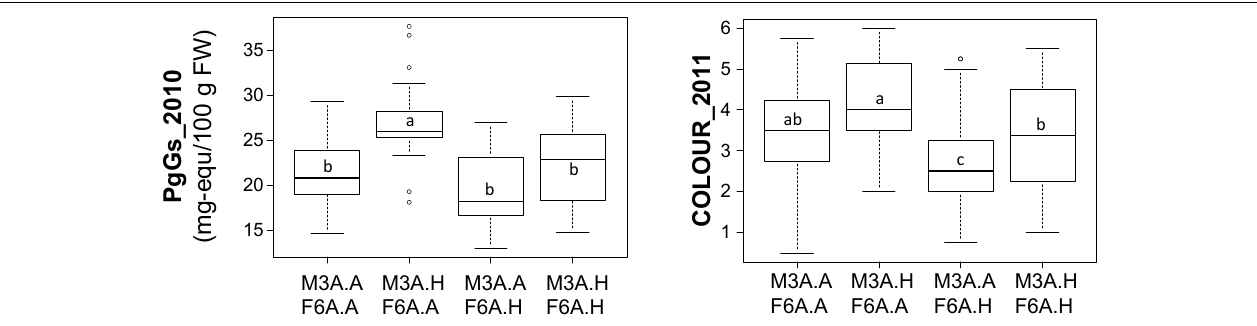
FIGURE 2 | Contribution of the M3A and F6A quantitative trait loci (QTLs) to colour-related trait values. Effect of M3A and F6A alleles on PgGs content and COLOUR values. The allelic status (presence, H; absence, A) of the two markers, AX.89826440.M3A (M3A) and AX.89842368.F6A (F6A) is indicated on the abscissa. These markers were chosen because they were localised at the peak of colour-related QTLs (PgGs_2010 and COLOUR_2011) on M3A and F6A. Boxes represent the trait variation of individuals with the reported combination of alleles. Boxplots with the same letter are not significantly different (Kruskal–Wallis test, P <